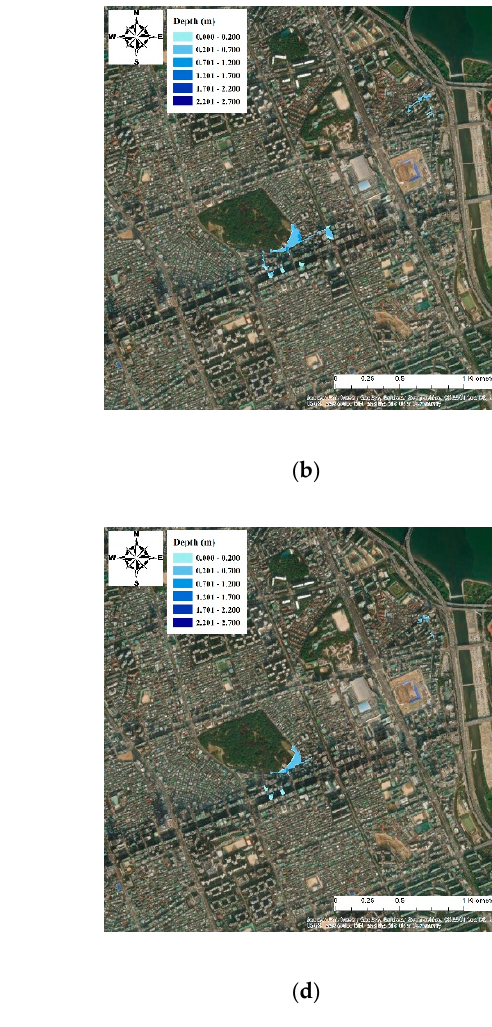
Figure 7. Sample minimum inundation maps applying 100-year, 1-h rainfall events with different Huff quartile distributions (( a – d ): 1st, 2nd, 3rd, and 4th quartile).